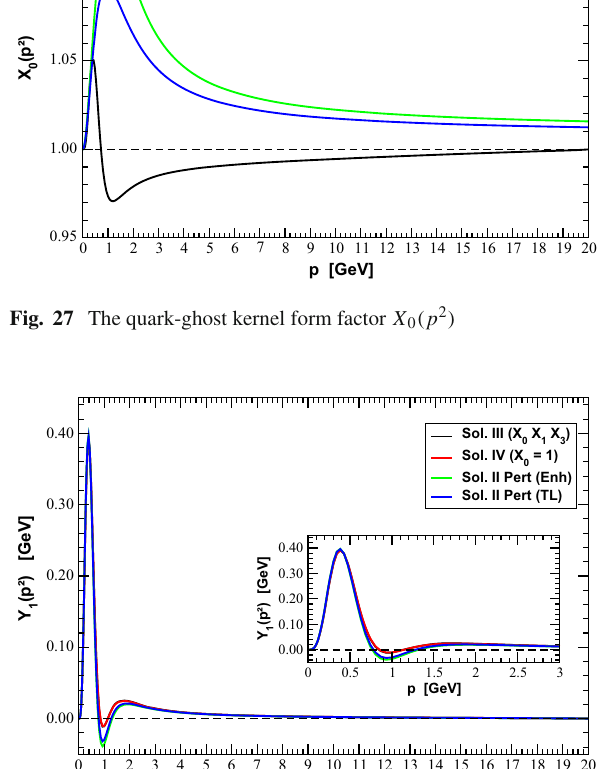
same function of the gluon momentum, with Y 1 ( p 2 ) being small for p (cid:3) 1 . 5 GeV and showing a sharp peak at p (cid:10) 400 MeV. Y 1 ( p 2 ) is positive defined except for a small range of momenta p ∈ [ 0 . 75 , 1 . 4 ] GeV where it takes small negative values.